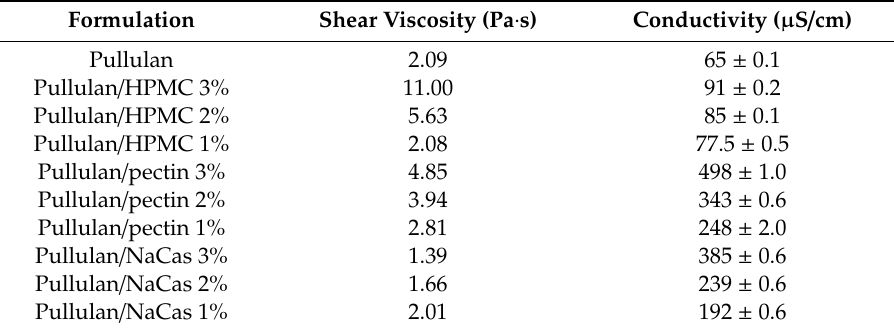
Table 1. Shear viscosity and conductivity values of the spinning